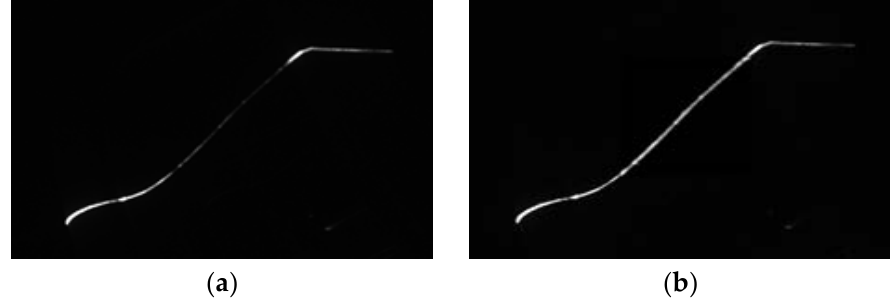
Figure 10. Stripe images before and after brightness enhancement. ( a ) Stripe image before enhancement; ( b ) stripe image after enhancement.